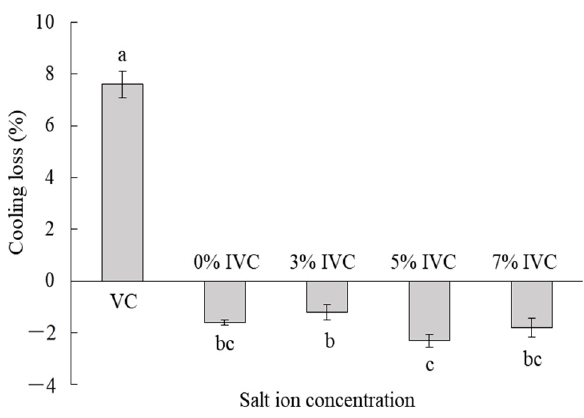
Figure 3. Effects of different immersion salt ion concentrations on the cooling loss of chicken drumsticks. VC: vacuum cooling; IVC: immersion vacuum cooling; 0%, 3%, 5%, and 7%: different salt ion concentrations. The data in the figure are expressed as means ± standard deviation. Different lower-case letters indicate significant differences between different groups. Positive values represent weight loss, whereas negative values represent weight gain.